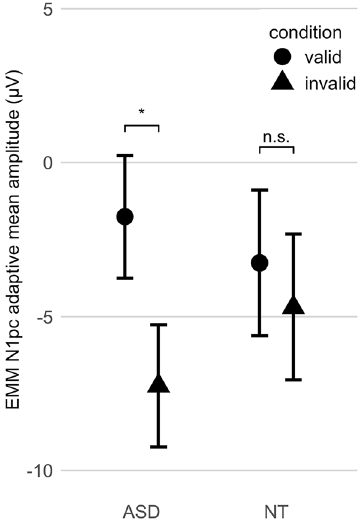
Figure 3. Significant modulation of N1pc amplitude by cue validity in ASD, but not in NT. EMM: estimated marginal means; * p < 0.001; n.s.: not significant; ASD: Autism Spectrum Disorder; NT: typically developing children; error bars: 95% confidence intervals. This figure was made using the R package ggplot2 68